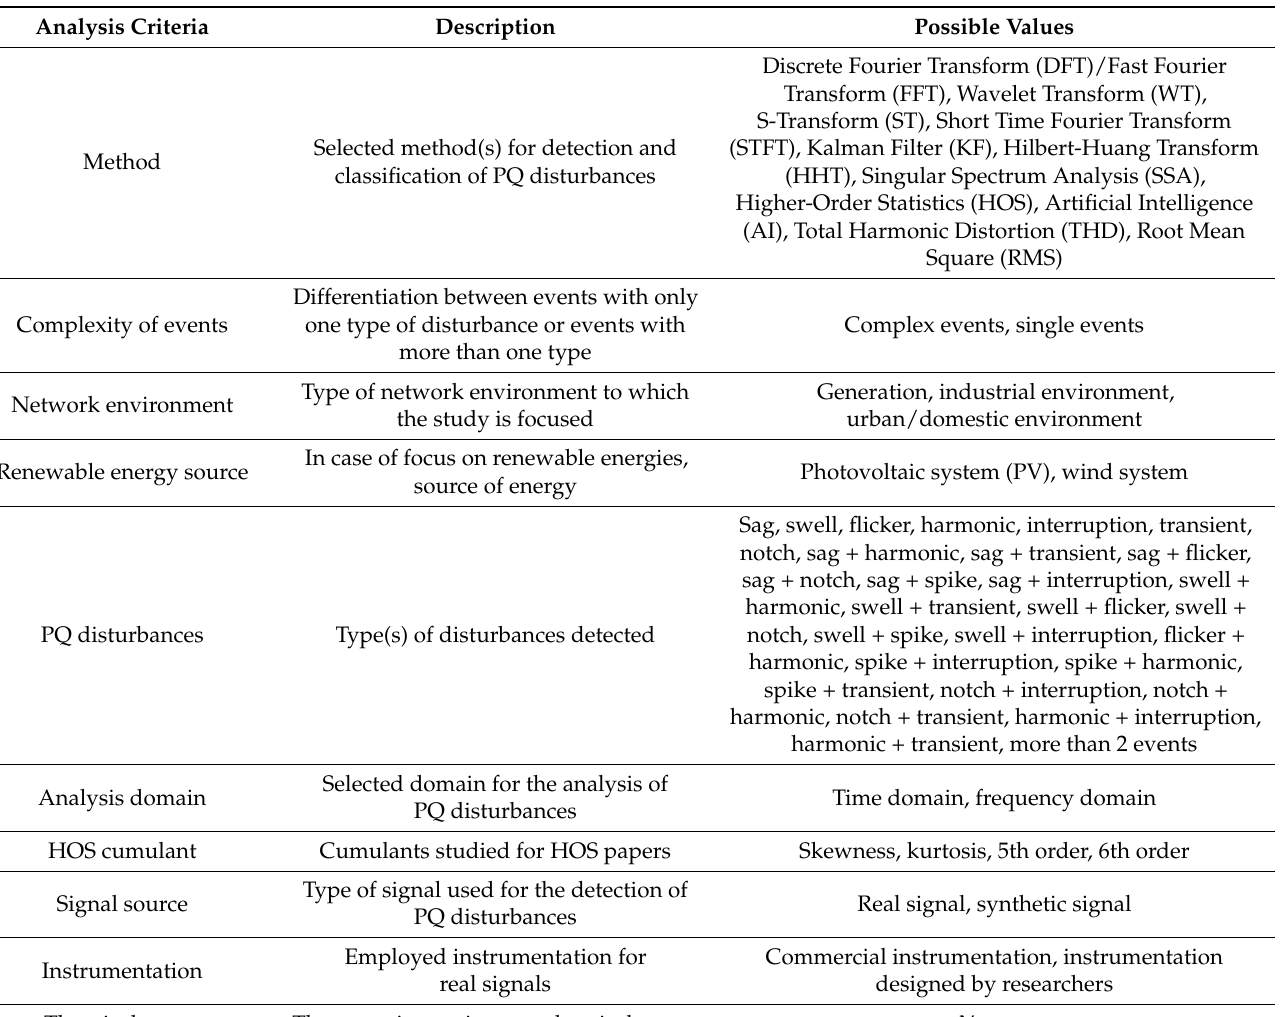
Table 1. Assessment criteria: An overview of analysis criteria define the collected data. Each item represents a property characterizing the techniques applied in the respective articles, and a short description and possible values are